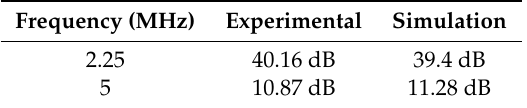
Table 3. Comparison of backwall amplitude reduction.